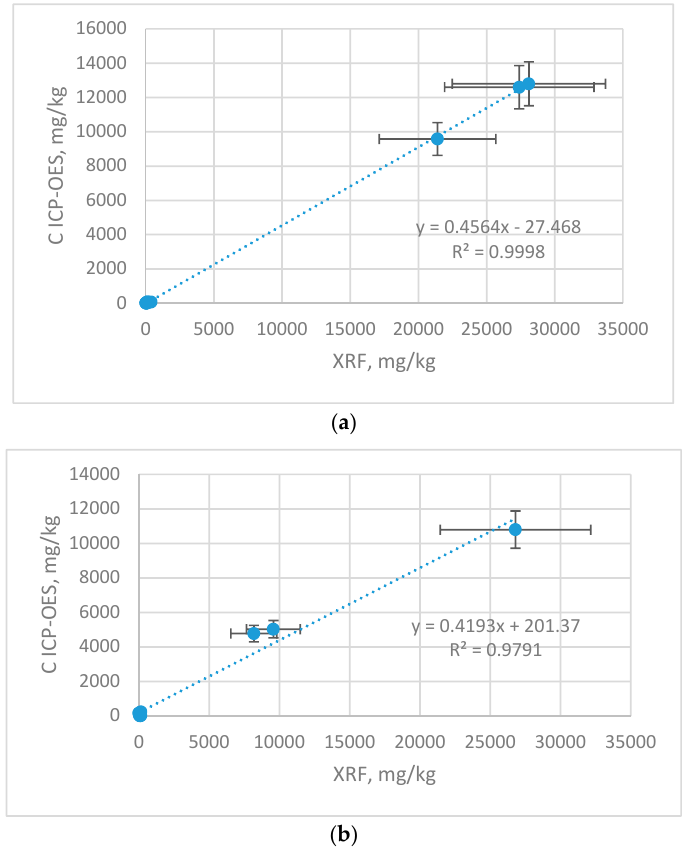
the measurement.